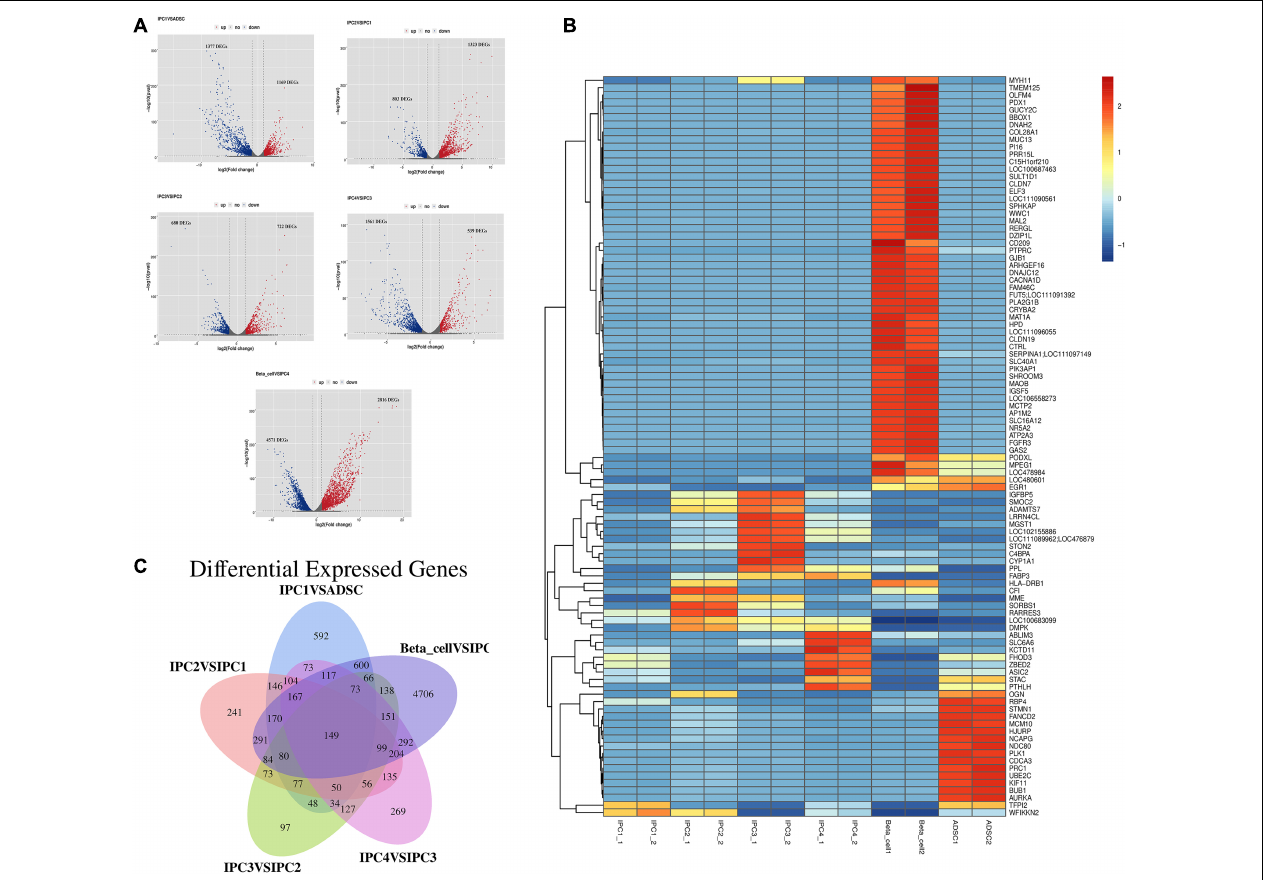
FIGURE 4 | Differential expression genes analysis and clustering analysis. (A) Volcanic maps of the DEGs. Blue dot and green dot represent that the expression level of genes has difference, the black dot represents no difference. (B) Clustering analysis. The abscissa is the sample, and the ordinate is the genes. Different colors indicate different gene expression level, and the color ranges from blue to white to red, indicating low to high expression levels. (C) Venn diagrams was constructed to compare the spectra of DEGs with each